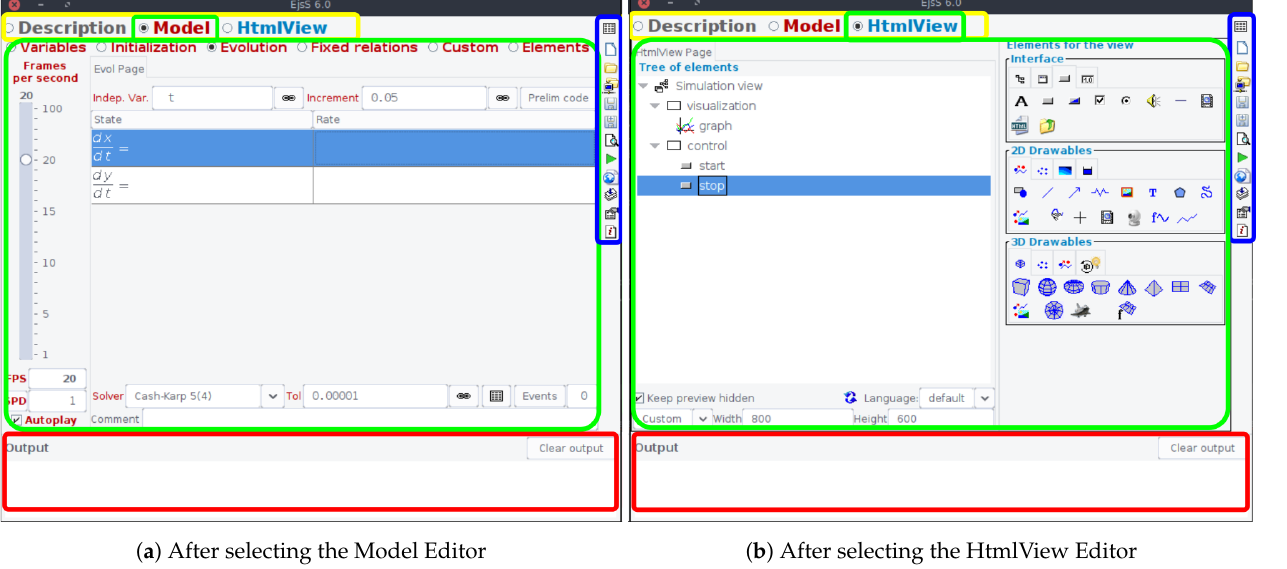
Figure 1. Screenshots of EJsS standard